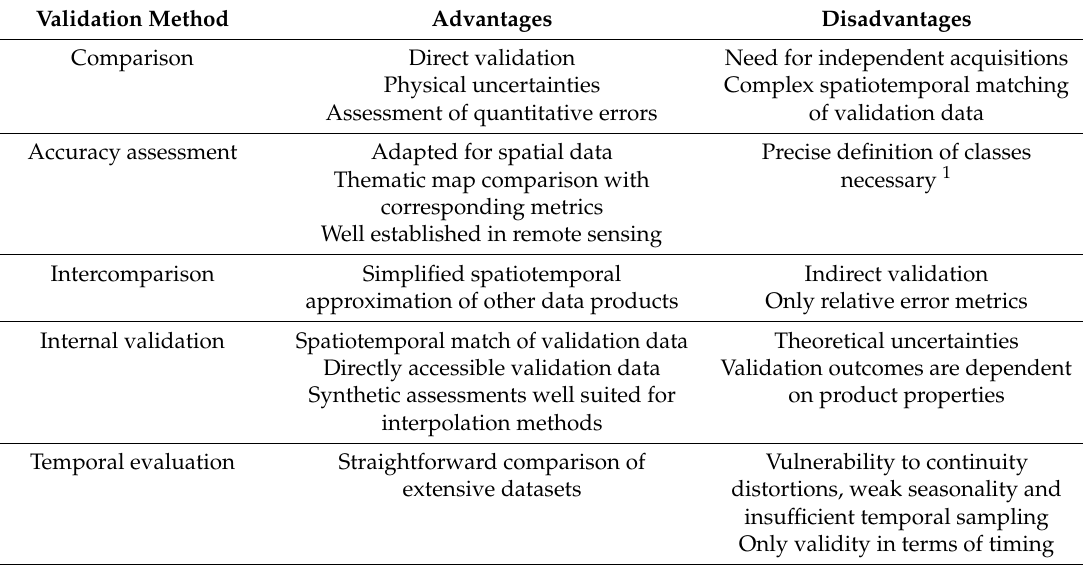
Table 1. Advantages and disadvantages of validation method